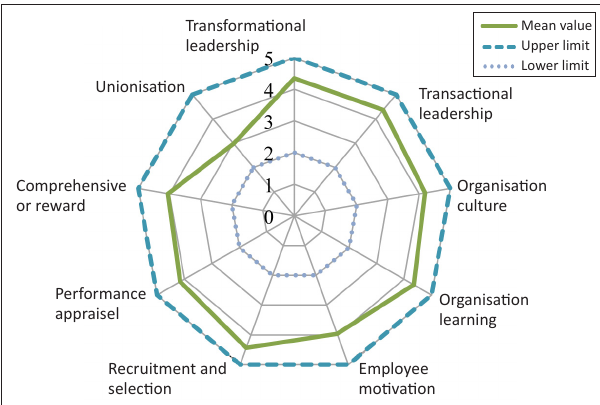
FIGURE 1: Radar diagram for independent